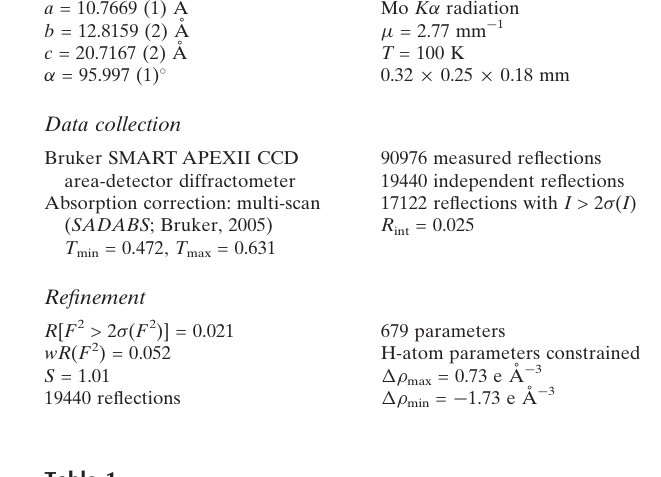
Hydrogen-bond geometry (A˚ , (cid:3)